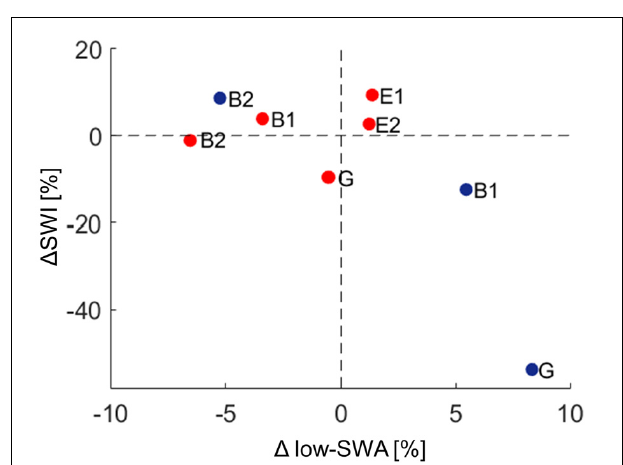
FIGURE 5 | Relationship between spike-wave index ( ∆ SWI) and ∆ low-slow wave activity (low-SWA) for DOWN (red dots) and UP (blue dots) stimulation pooled. Data points for each patient are shown for the UP and DOWN stimulation separately ( ∆ SWI [%] = (SWI Stim − SWI after )/SWI pre ) ∗ 100; ∗ 100. A positive ∆ low-SWA [%] = (low-SWA − low-SWA after STIM )/low-SWA pre ) ∆ SWI/ ∆ low-SWA value indicates that SWI/low-SWA was higher during stimulation, whereas a negative value indicates that SWI/low-SWA was lower during stimulation than after the stimulation block. G, generalized spike waves in sleep EEG; B, BECTS; E,